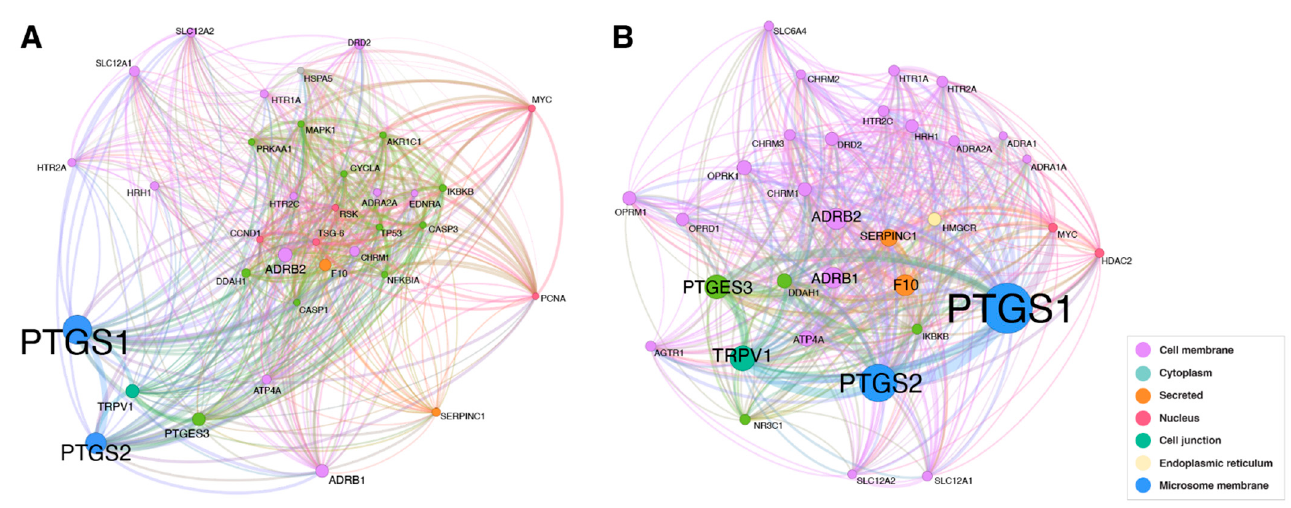
Figure 3. Molecular target networks for severe ( A ) and non-severe ( B ) COVID-19 (only nodes with three or more edges are shown); ADRA1A/2A : Alpha-1A/2A adrenergic receptor; ADRB1/2 : Beta-